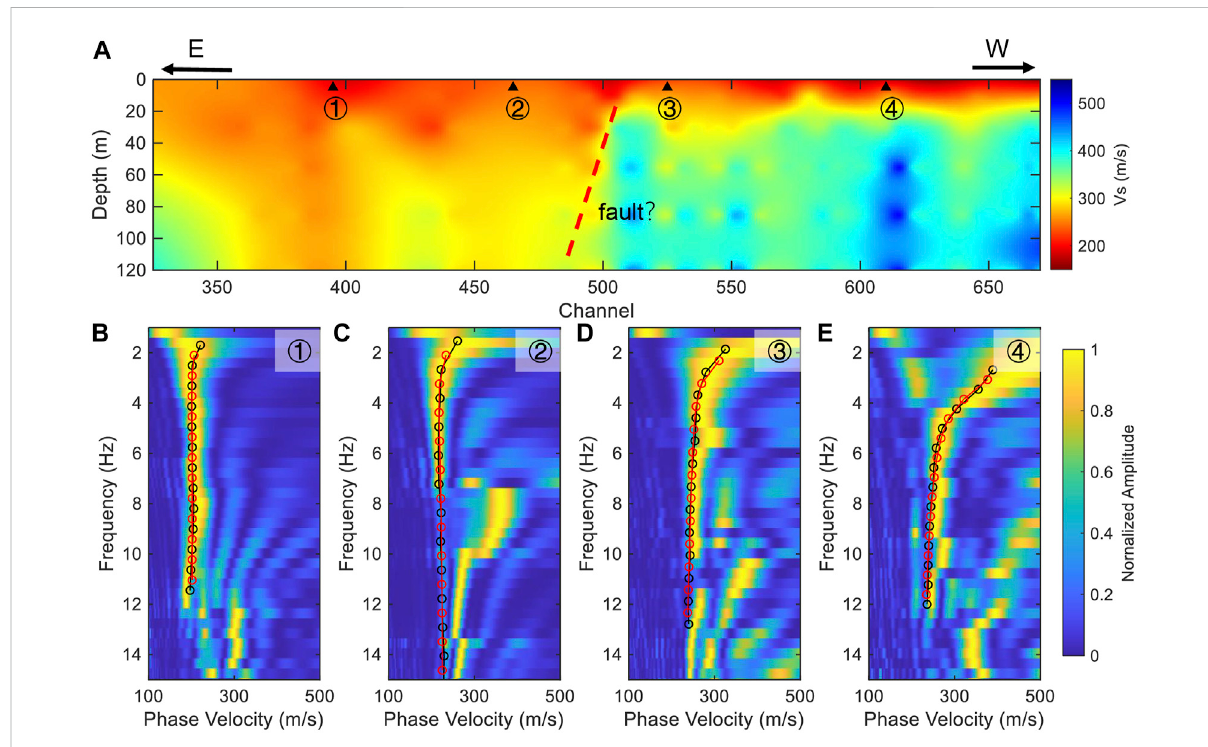
FIGURE 7 (A) The S-wave structure beneath theJinniu Road. (B – E) are thedispersion curves fi tting,corresponding to thepositionsofthefour triangles in (A) . The black lines and red lines indicate the observed dispersion curves and the theoretical dispersion curves predicted by the inverted models,